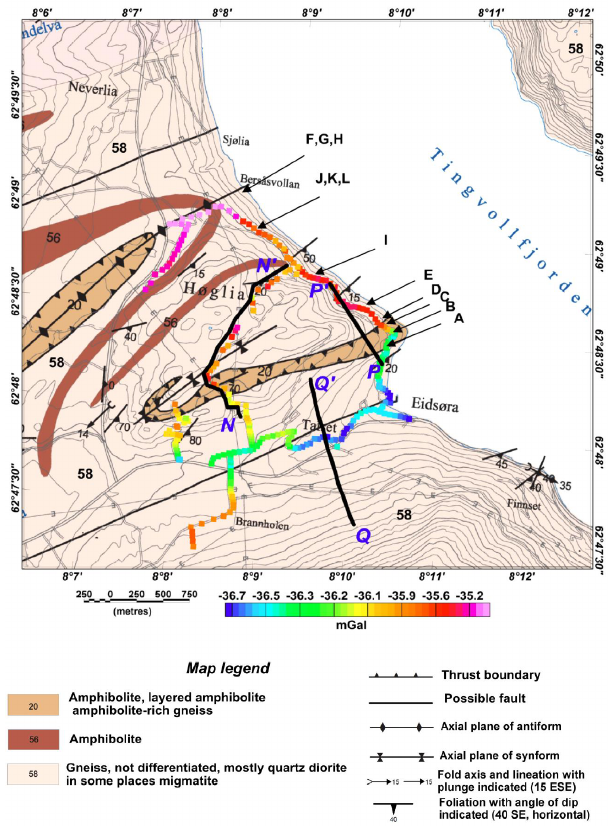
Fig. 5. Bouguer anomalies calculated using a reduction density of 2790kgm − 3 and superposed on the geological map (Tveten et al., 1998). NN 0 is the traverse used to determine the reduction density (Fig. 4). PP 0 and kgm − 3 are profiles shown in Figs. 7 and 8 re- spectively. Letters in black represent petrophysical sampling sites (Biedermann,